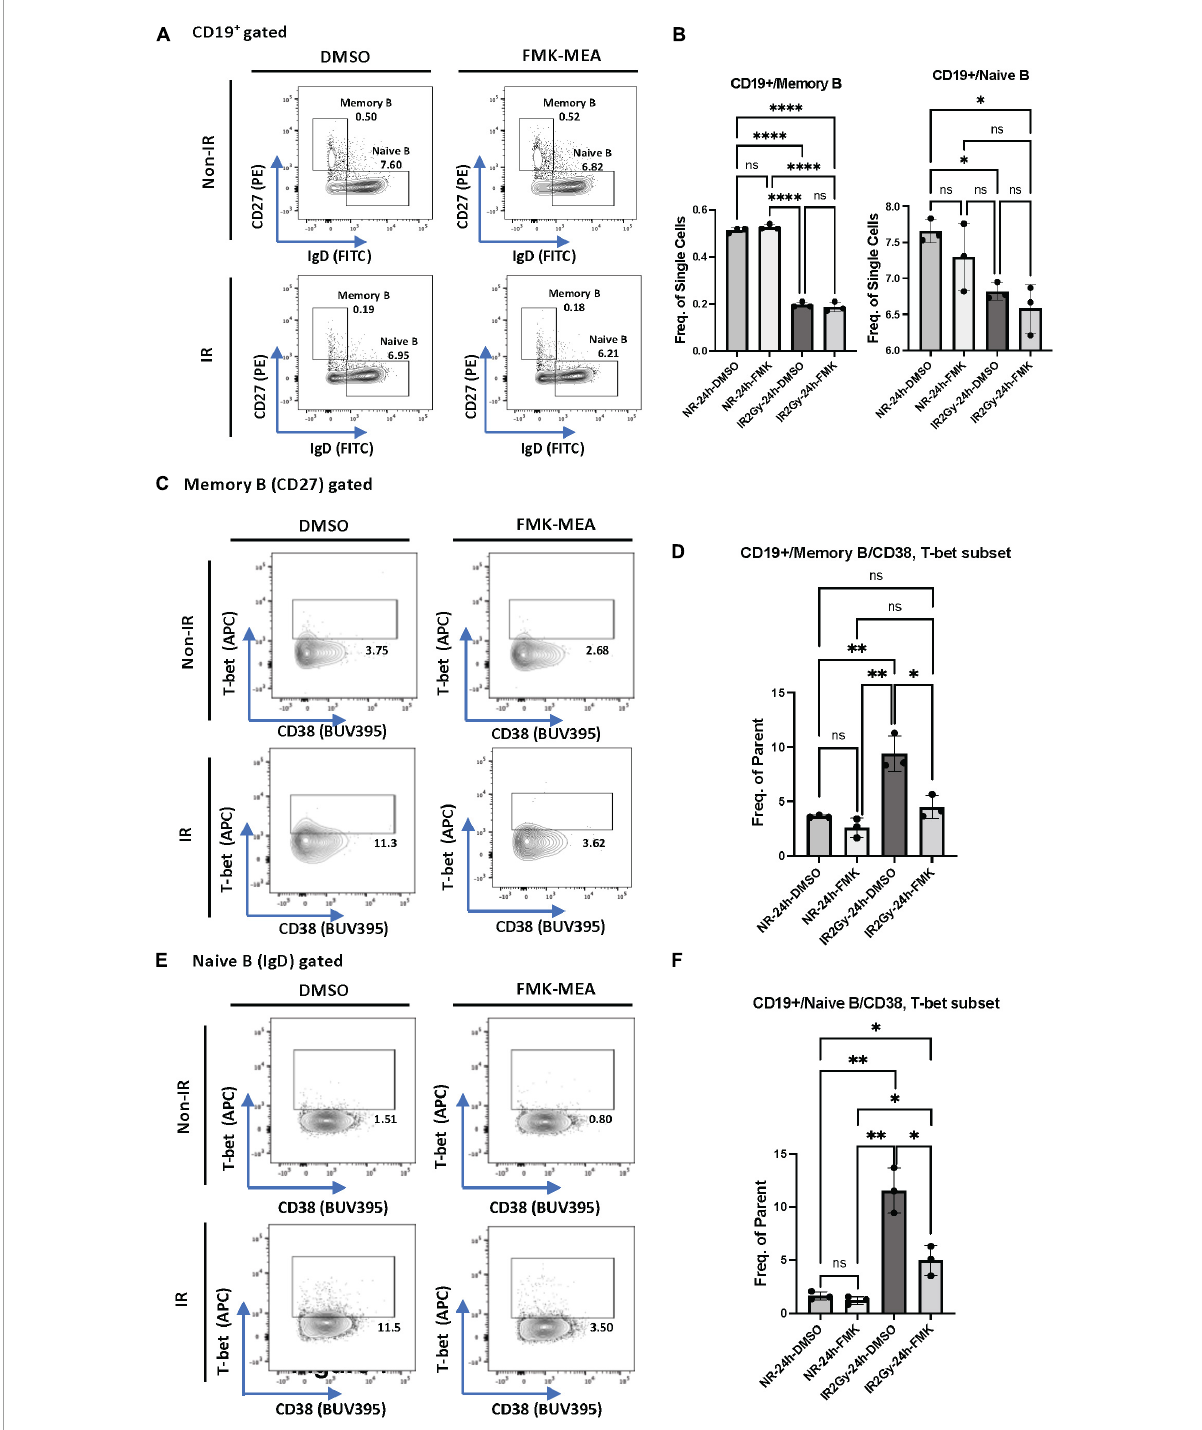
FIGURE6 IR-induced CD38 + T-bet + CD19 + B cell via p90RSK activation. (A) Memory and naive B cell gating among CD19 + B cells. (B) Frequency of memory B cells (Left) and naive B cells (Right) among CD19 + cells 24 h after irradiation/non-irradiation with/without FMK-MEA. (C) Representative FACS plots for T-bet + memory cells and their frequency among CD19 + B cells (D) 24 h after irradiation/non-irradiation with/without FMK. (E) Representative FACS plots for T-bet + naive B-cells and their frequency among CD19 + B cells (F) 24 h after irradiation/non-irradiation with/without FMK. N = 3 for each group, and the experiments were done more than twice. Mean ± SD, ∗ p < 0.05, ∗∗ p < 0.01, and ∗∗∗∗ p <